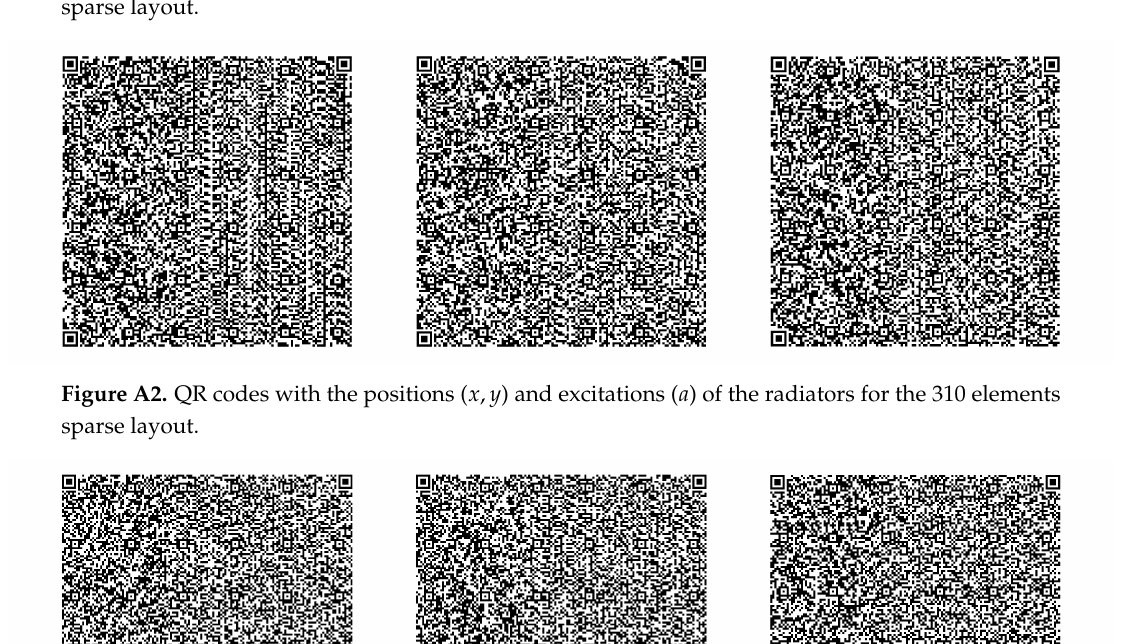
Figure A1. QR codes with the positions ( x , y ) and excitations ( a ) of the radiators for the 213 elements sparse layout.